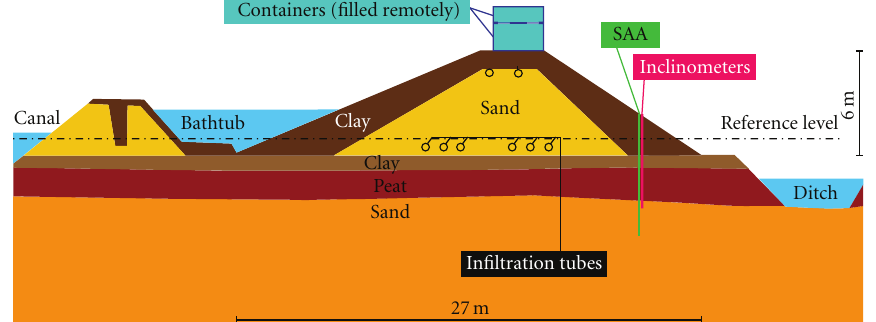
Figure 10: Cross-section of instrumented stability test levee.